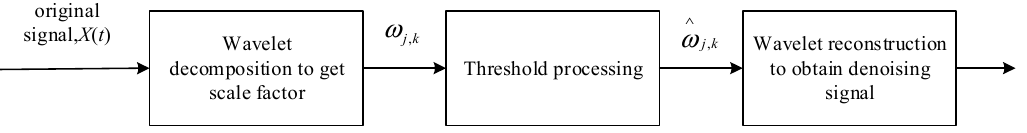
Figure 2. The process of wavelet threshold noise reduction.